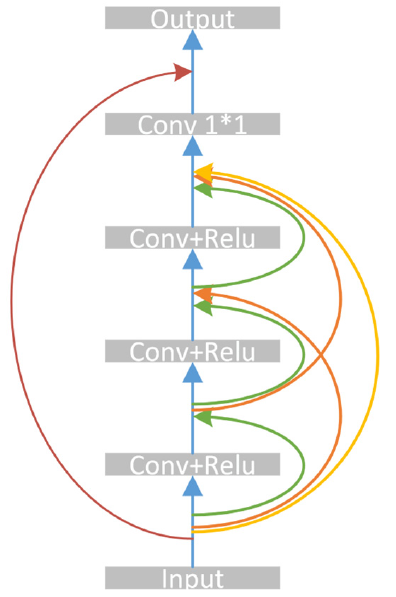
Figure 4. The structure of the RDB unit. The yellow, orange, and green lines in the figure represent the merged features in the channel dimension, and the red line represents the summation of the original features with the features after the convolution layer.